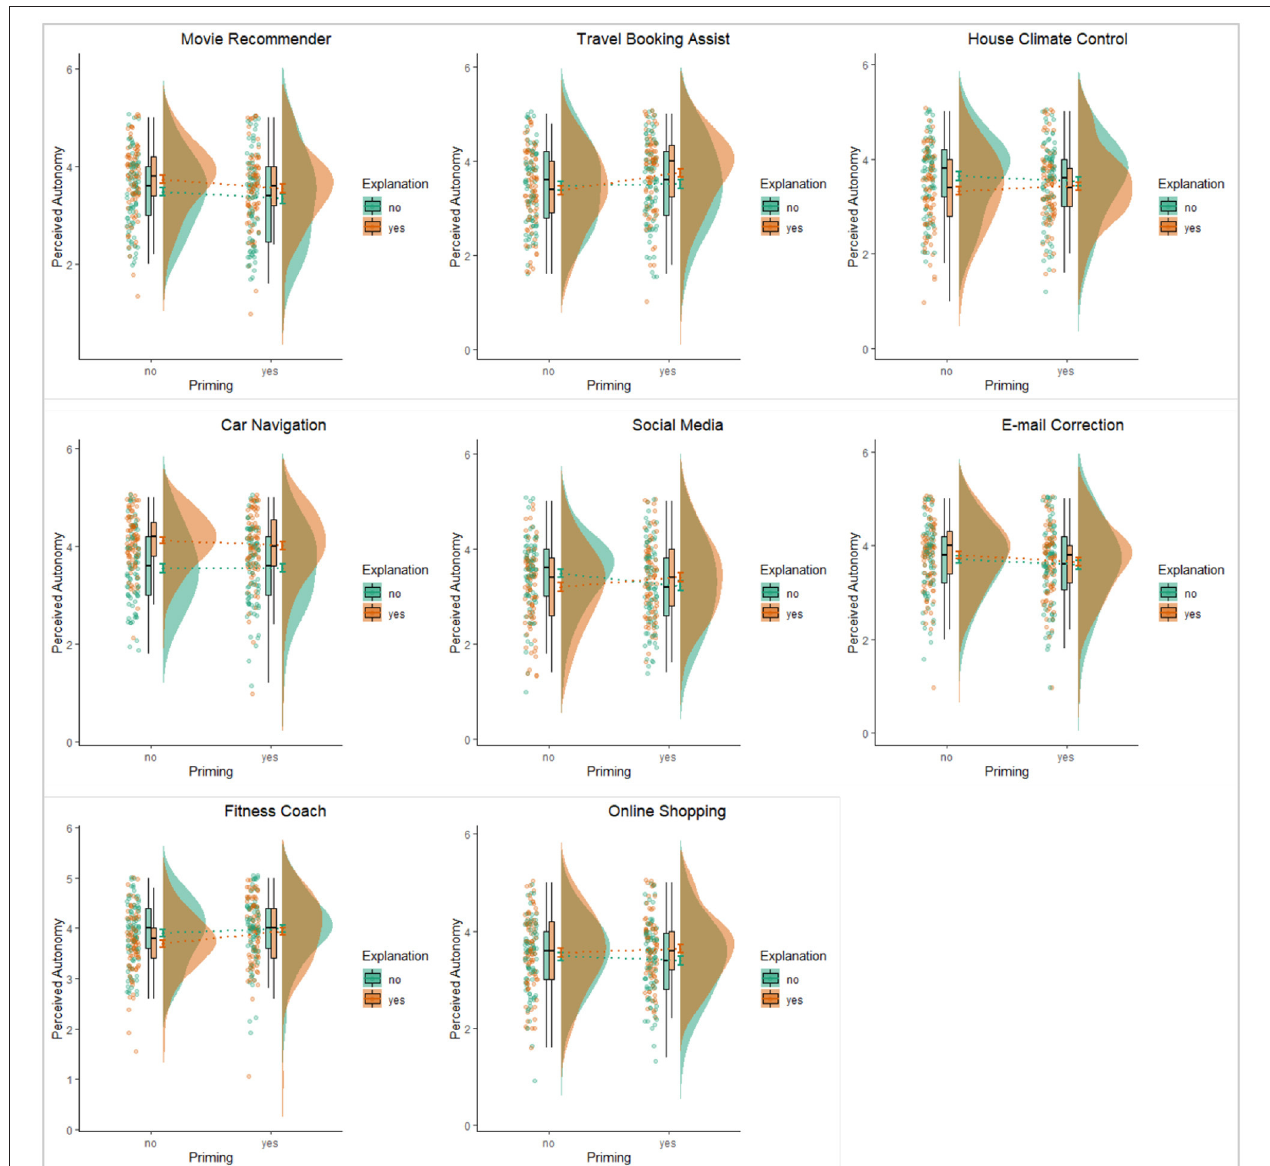
FIGURE 4 | Visualization of the effects of explanation and awareness on perceived autonomy for the eight specific application